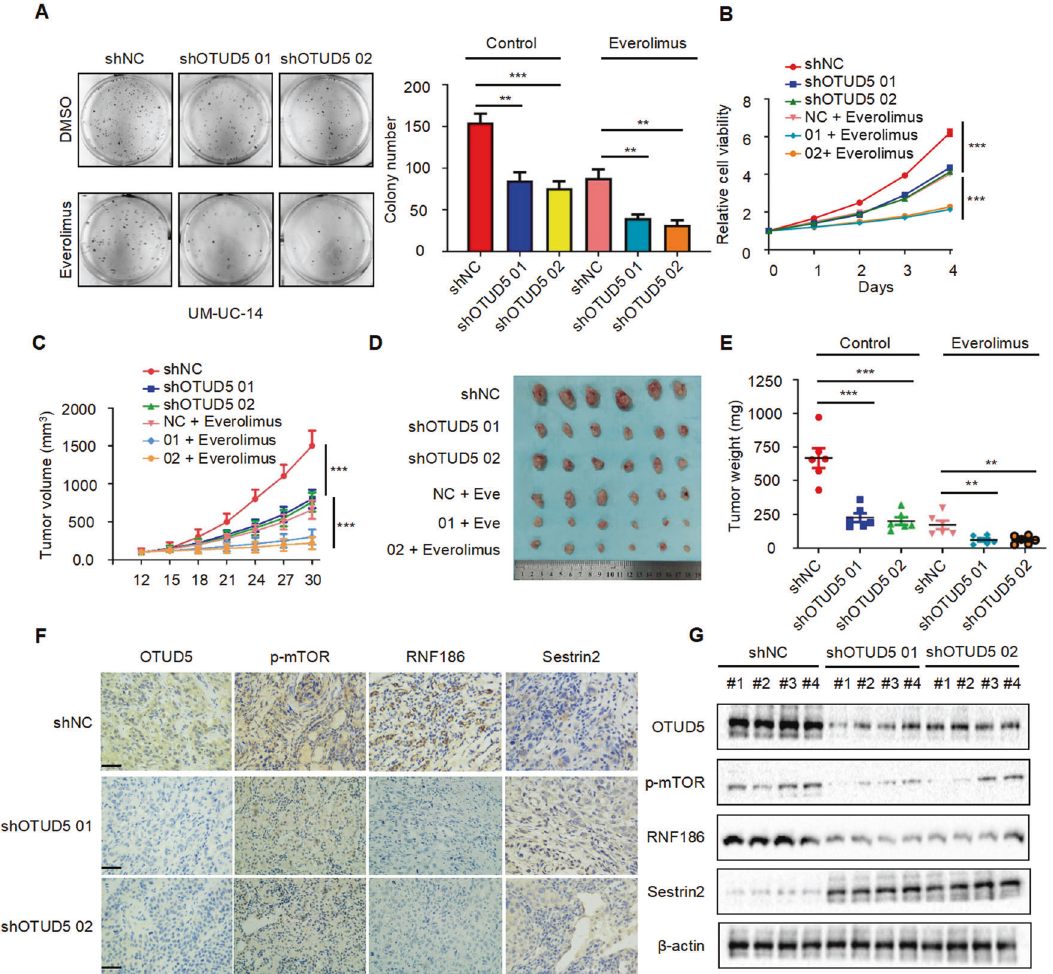
Fig. 6 OTUD5 knockdown combined with everolimus inhibits bladder cancer growth in vitro and in vivo. A Colony formation assays and quanti fi cation results of UM-UC-14/WT and UM-UC-14/shOTUD5 cells treated with or without everolimus (10 nM). ** P < 0.01, *** P < 0.001. B The growth curves of UM-UC-14/WT and UM-UC-14/shOTUD5 cells treated with or without everolimus (10 nM). *** P < 0.001. C The growth curves of xenografts in different treatment groups. Tumor volumes were measured every three days from day 12 to day 30. *** P < 0.001. D Illustration of tumors excised from male nude mice in each treatment group. E After 30 days, the nude mice were sacri fi ced, and UM-UC-14 cell xenografts were weighed. ** P < 0.01, *** P < 0.001. F The expressions of OTUD5, p-mTOR, RNF186 and sestrin2 in the xenograft tumors were measured by immunohistochemistry. (Scale bar, 20 µm). G The expressions of OTUD5, p-mTOR, RNF186 and sestrin2 in the xenograft tumors were measured by Western blot. β -actin was used as the loading control. n = 6 mice per treatment group, data are presented as mean ±